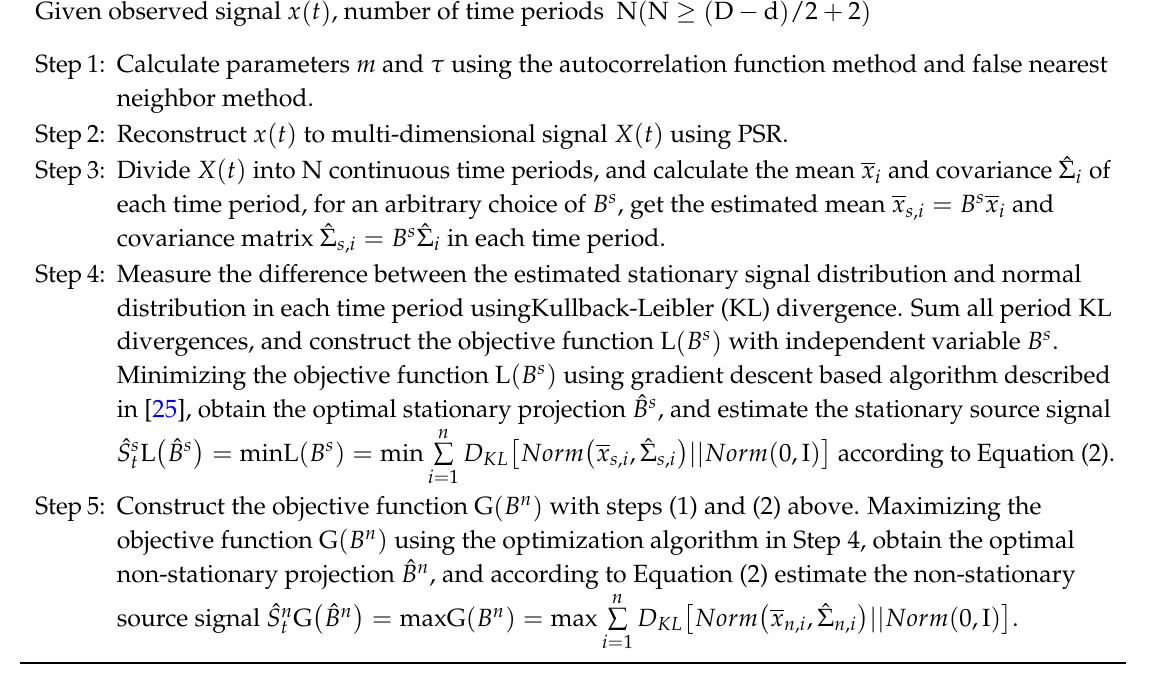
Algorithm 1. Finding non-stationary subspaces by SSA and